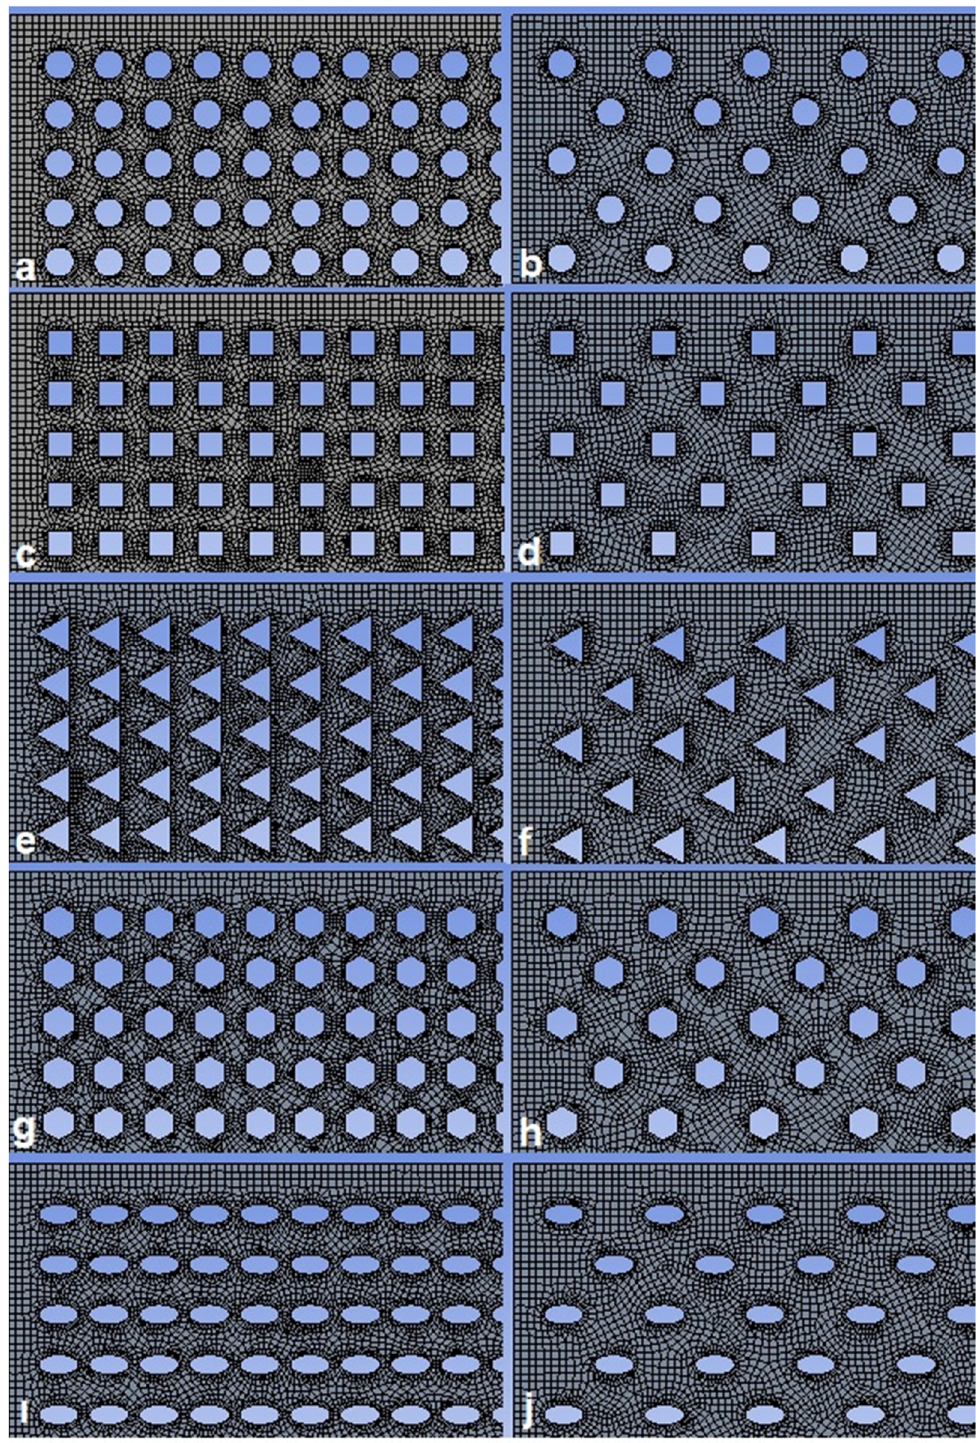
Figure 1: Finite element models of perforated sheet metals ( a ) circle ( linear ) , ( b ) circle ( staggered ) , ( c ) square ( linear ) , ( d ) square ( stag - gered ) , ( e ) triangle ( linear ) , ( f ) triangle ( staggered ) , ( g ) hexagon ( linear ) , ( h ) hexagon ( staggered ) , ( i ) ellipse ( linear ) , and ( j ) ellipse ( staggered )